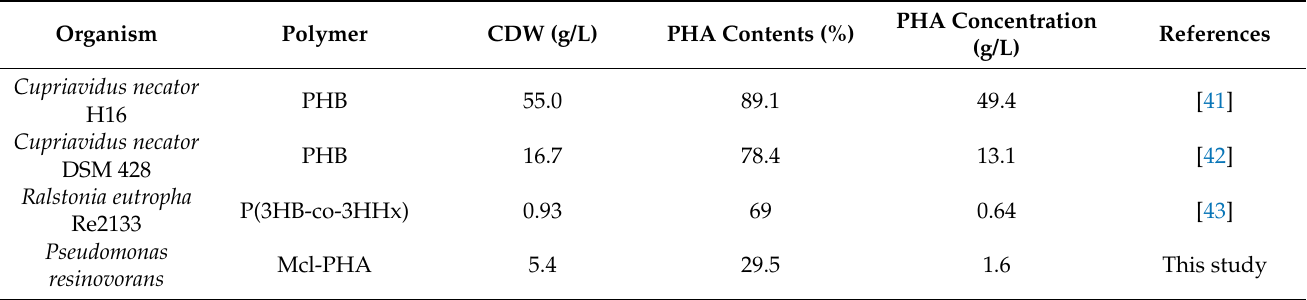
Table 4. Production of various PHA using SCGs